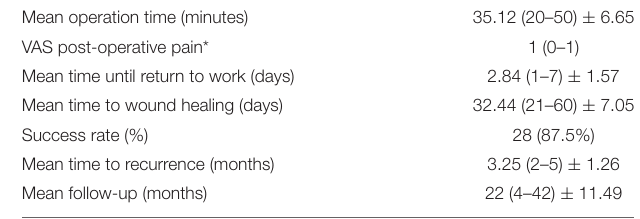
TABLE 2 | Procedural